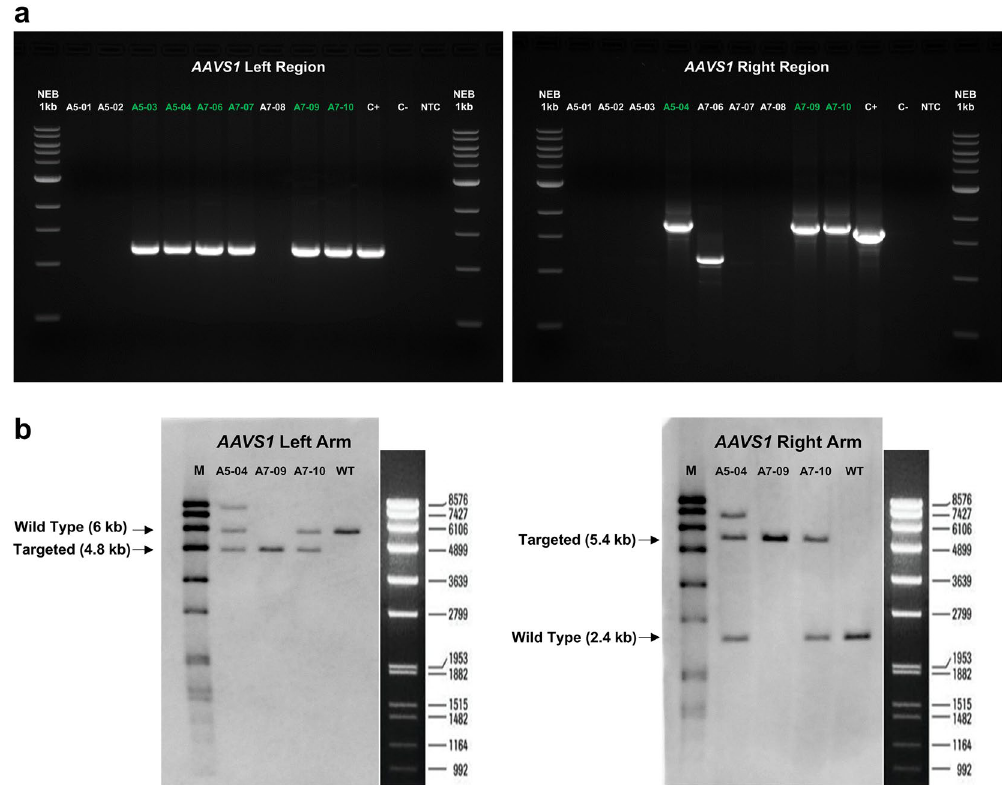
Figure 2. Genetic screening. ( a ) Junction PCRs were performed using locus-specific primers that bind to genomic sequences outside of the homology regions in combination with vector-specific primers. Expected fragment sizes for positive samples: 1196 bp for the left region and 1789 bp for the right region. Three clones tested positive in the screening that contained correctly integrated donor DNA at both ends. C+: positive control hiPSC line containing genome integrated eGFP sequence in the AAVS1 locus, C-: negative control SBAD2 hiPSC line, NTC: no template control. The original uncropped gels are presented in Supplementary Figure S1. ( b ) Southern blot analysis of the candidate clones (A5-04, A7-09, A7-10) and negative control SBAD2 hiPSC line. gDNA samples were digested with Nco I or Apa I restriction enzymes and tested with AAVS1 -LHA or AAVS1 -RHA specific probes, respectively. WT: negative control SBAD2 hiPSC line, M: DIG-labeled DNA Molecular Weight Marker VII (Roche), the ladder scale specified by the manufacturer is shown on the right side of the blots. The original uncropped blots are presented in Supplementary Figure